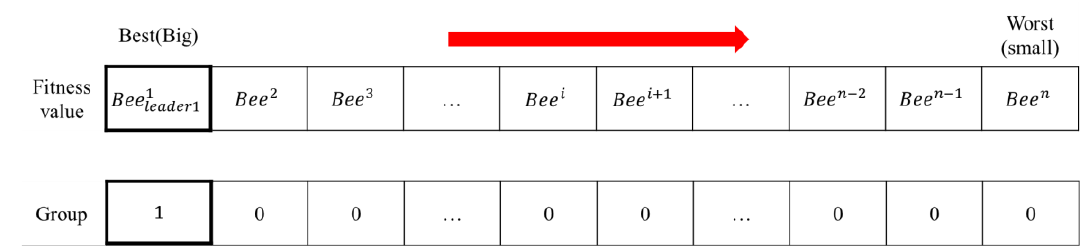
Figure 14. Second grouping of bees.